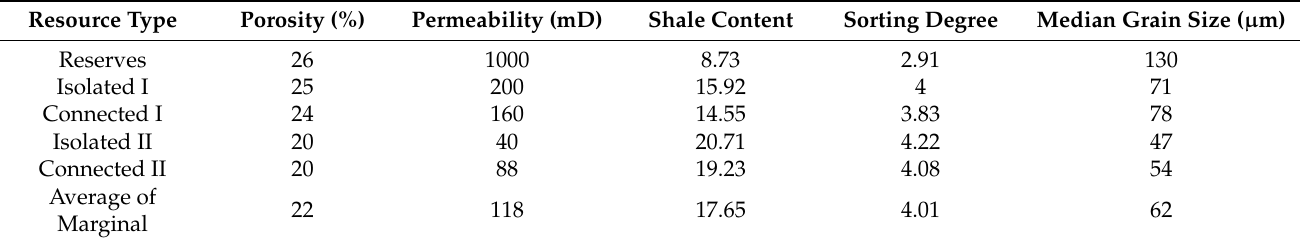
Table 2. Average properties for different resource